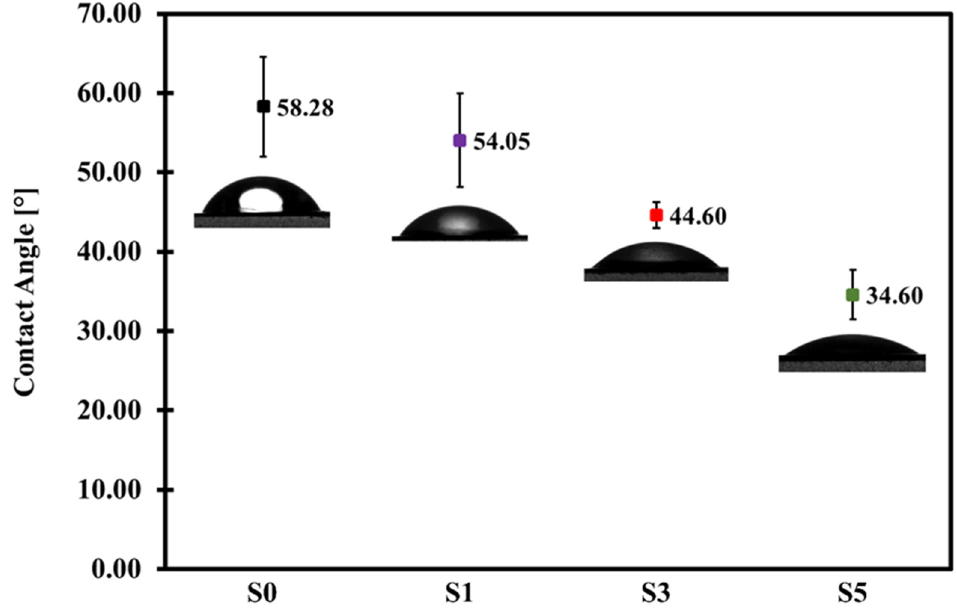
Figure 8. Static water contact angle (WCA) of pristine PES (S0), and MCC-incorporated PES mem- branes with 1 wt.% MCC (S1), 3 wt.% MCC (S3), and 5 wt.% MCC (S5).